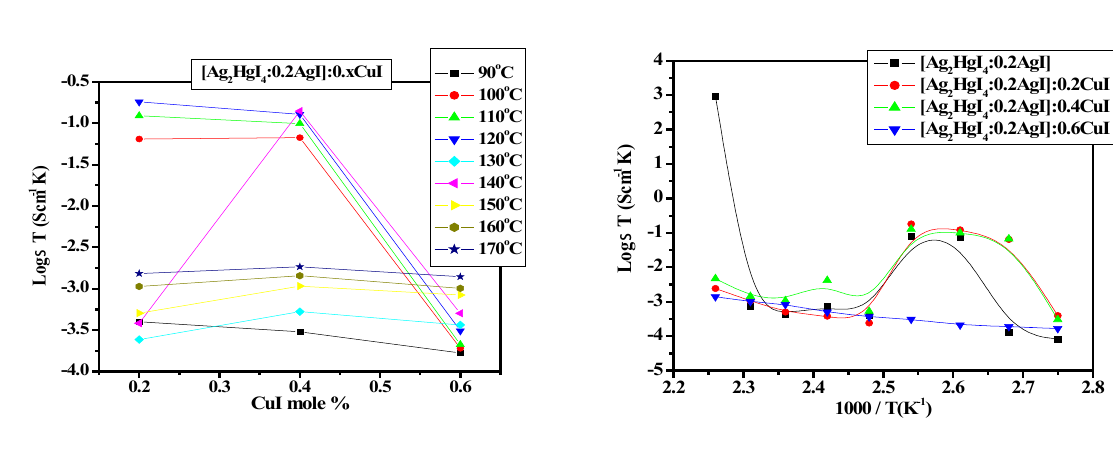
Figure 3. Log σ T vs. t (min) plots for mixed composite systems